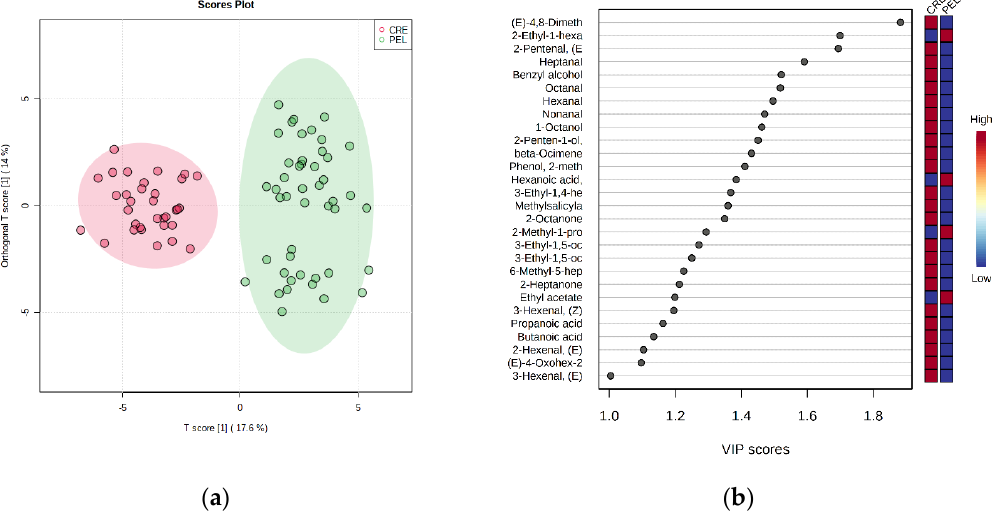
Figure 5. ( a ) OPLS − DA scores plot (green dots — PEL; red dots — CRE). The colored ellipses represent the 95% confidence region. ( b ) Volatile compounds with VIP score > 1. The color bars on the right indicate the normalized content of each volatile compound in the respective class.